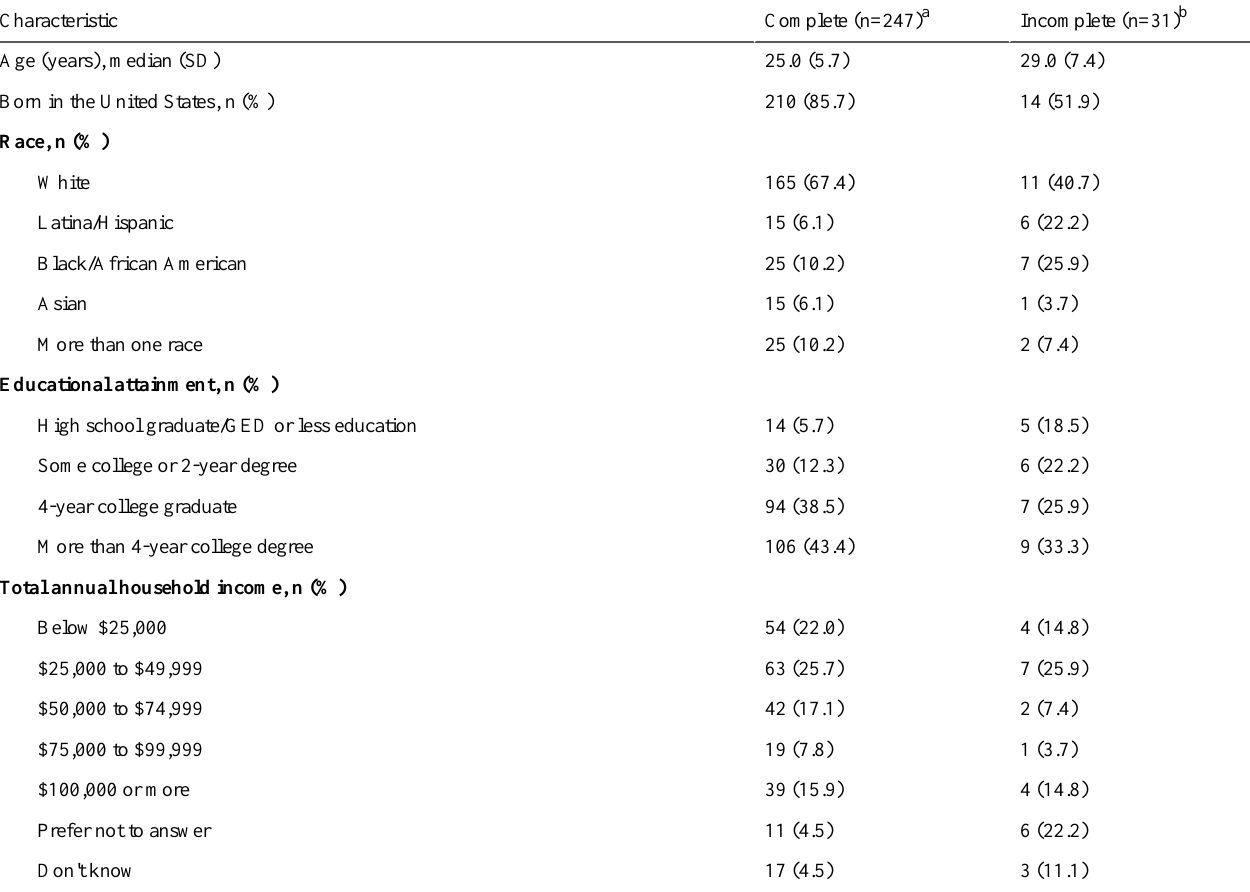
Table 3. Demographic characteristics by survey completion status